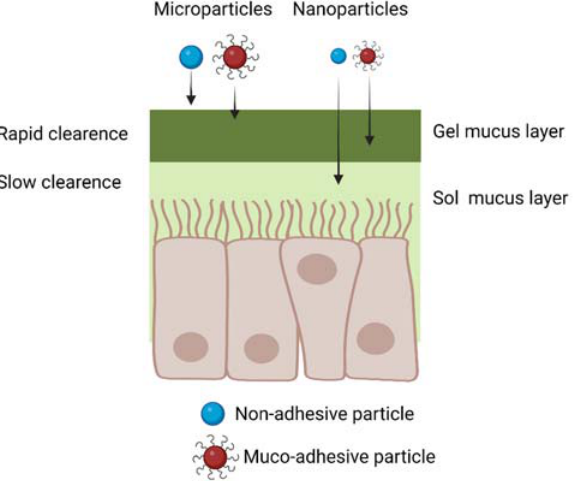
Figure 6. Schematic representation of micro- and nanoparticle diffusion through the nasal mucus considering both muco-adhesive and non-muco-adhesive particles. Created with BioRender.com. Table 2collects exemplary types of nanocarriers exploited for IN drug delivery.